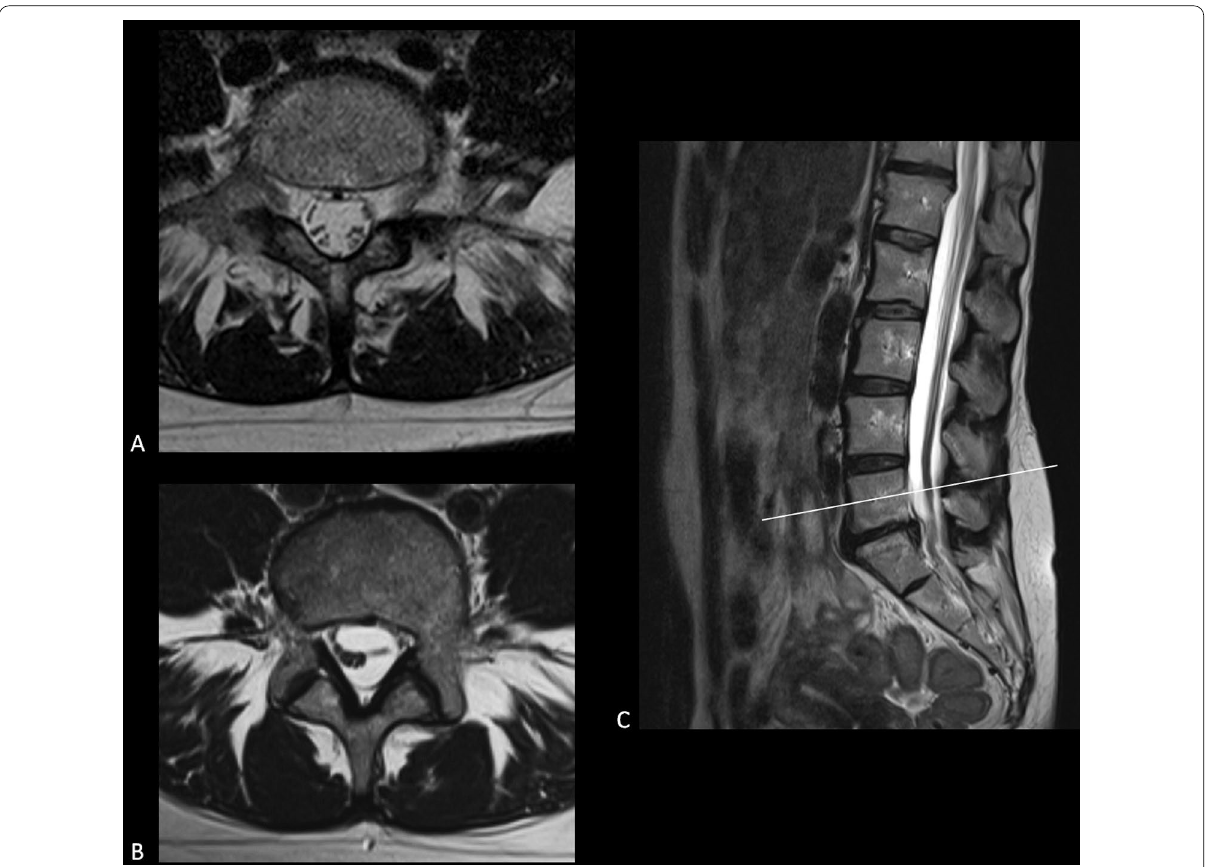
Fig. 9 T2-weighted MRI of the same FBBS patient at two-time intervals. A First available axial T2-weighted MRI section at the level of the fifth lumbar vertebra. Cauda equina roots are seen to float in ample cerebrospinal fluid. B Axial T2-weighted MRI section at the level of the fifth lumbar vertebra of the same patient after spinal intervention at level L5–S1. The patient complains of recurrent right-sided leg pain, sensory changes, and motor weakness. MRI show new clumping of the cauda equina roots on the right side of the dural sac. These features were consistent with arachnoiditis. C Mid-sagittal T2-weighted MRI, which also shows the clumping of cauda equina